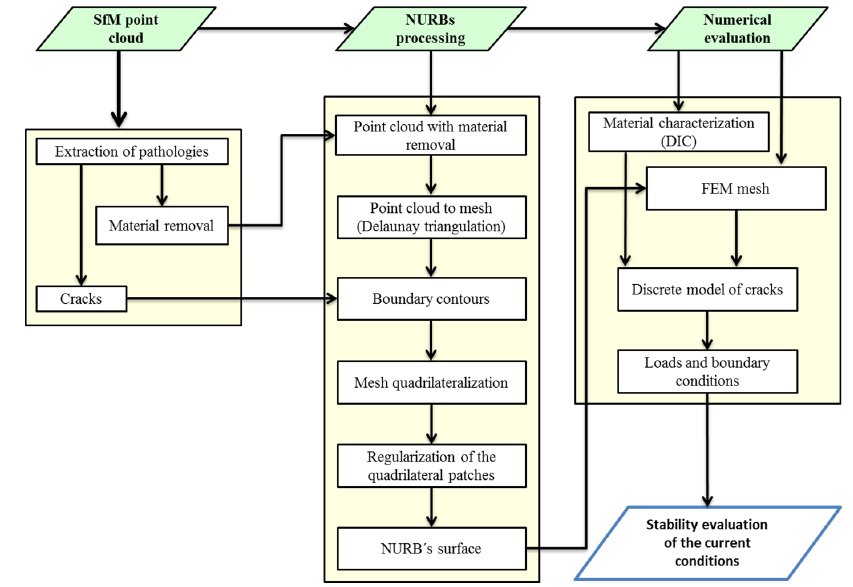
Figure 11. Proposed workflow for the study of the current stability of the construction.